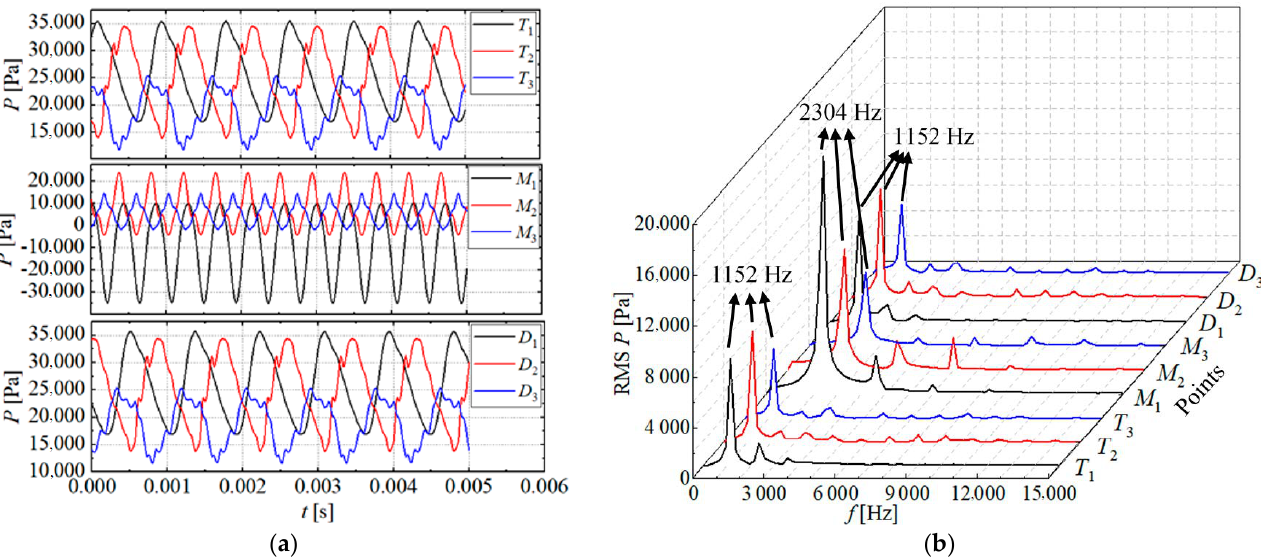
Figure 10. The pressure pulsations on monitoring points T 1 ~T 3 , M 1 ~M 3 and D 1 ~D 3. ( a ) Time-domain plot. ( b ) Frequency- domain plot.